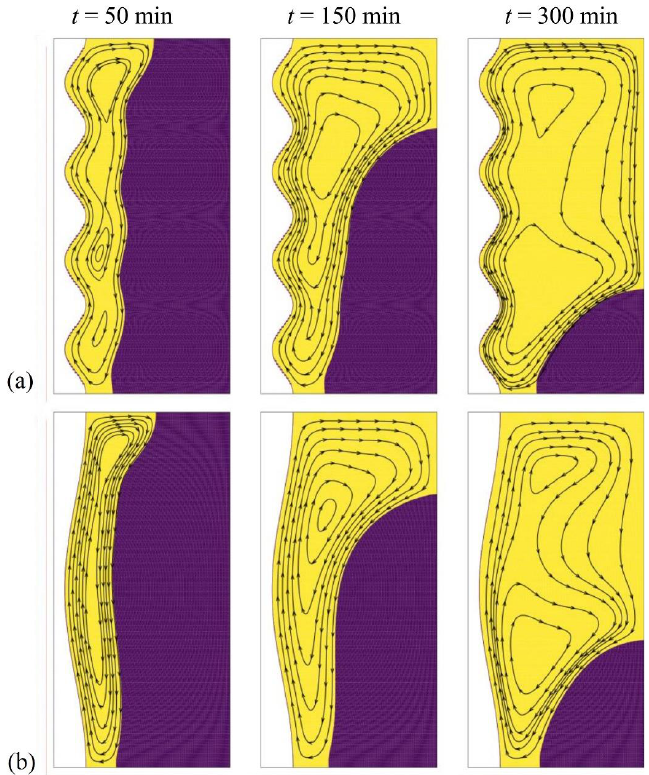
Figure 12. Effect of number of waves ( N ) on the streamlines, ( a ) Case 6 with N = 4 and ω na = 0.06; ( b ) Case 7 with N = 1 and ω na = 0.06.